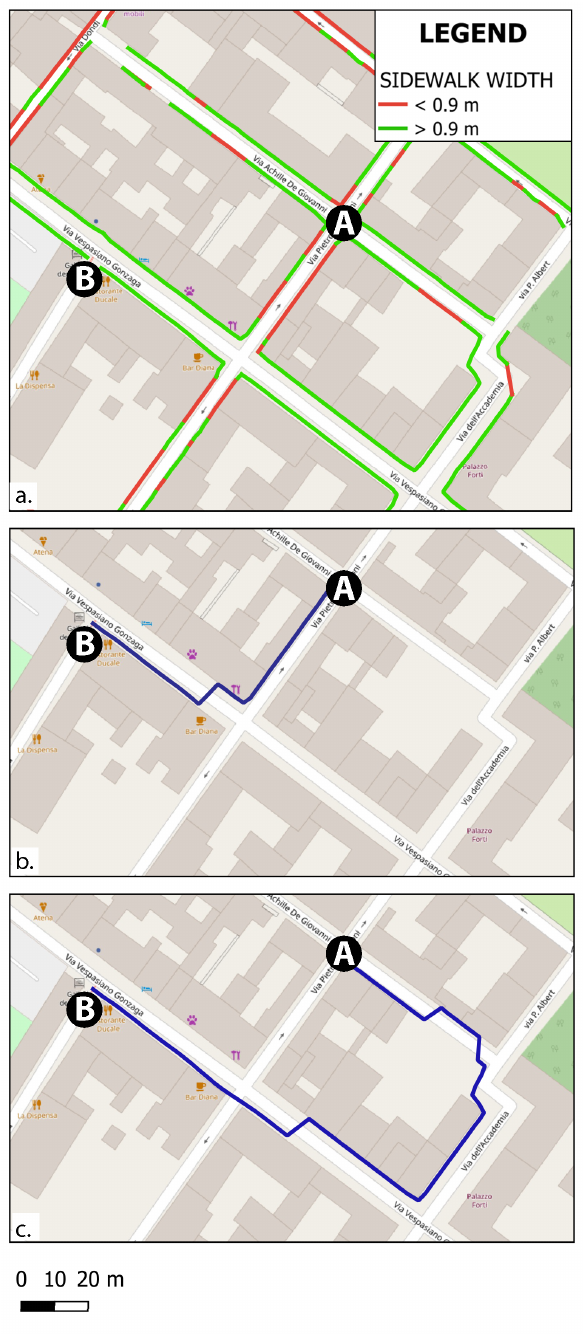
Figure 7. Test 1: computation of path considering width of side- walks as a constraints. The path is computed from point A to point B. (a) sidewalk width thematic map; (b) shortest path; (c) fastest path considering accessible width.